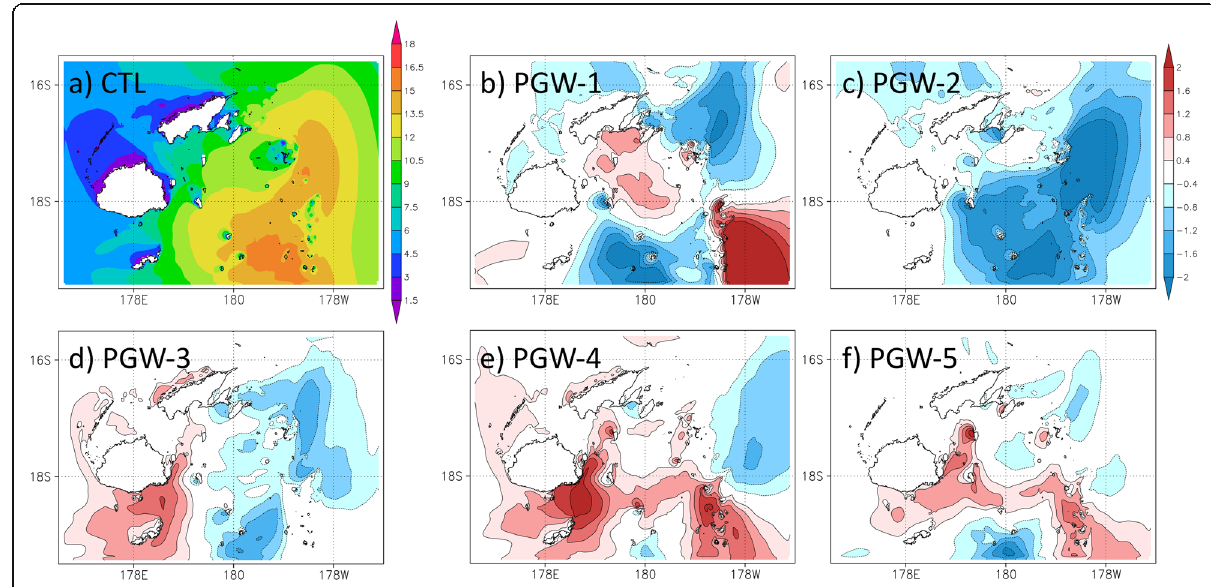
Fig. 12 Spatial distribution of the ensemble mean maximum significant wave height. a CTL results (same as Fig. 5a). b – f Difference in the ensemble mean maximum significant wave height between the CTL and each PGW ensemble simulation. The unit of the color bar is m.